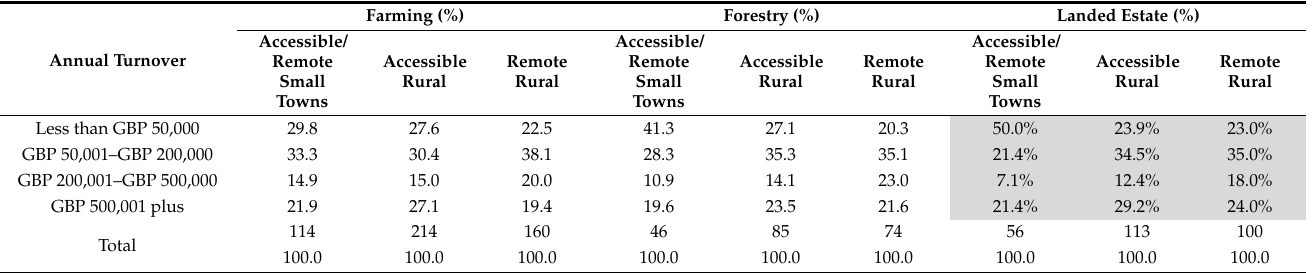
Table 4. Comparative analysis of annual turnover among non-land-based businesses in different rural town classifications.